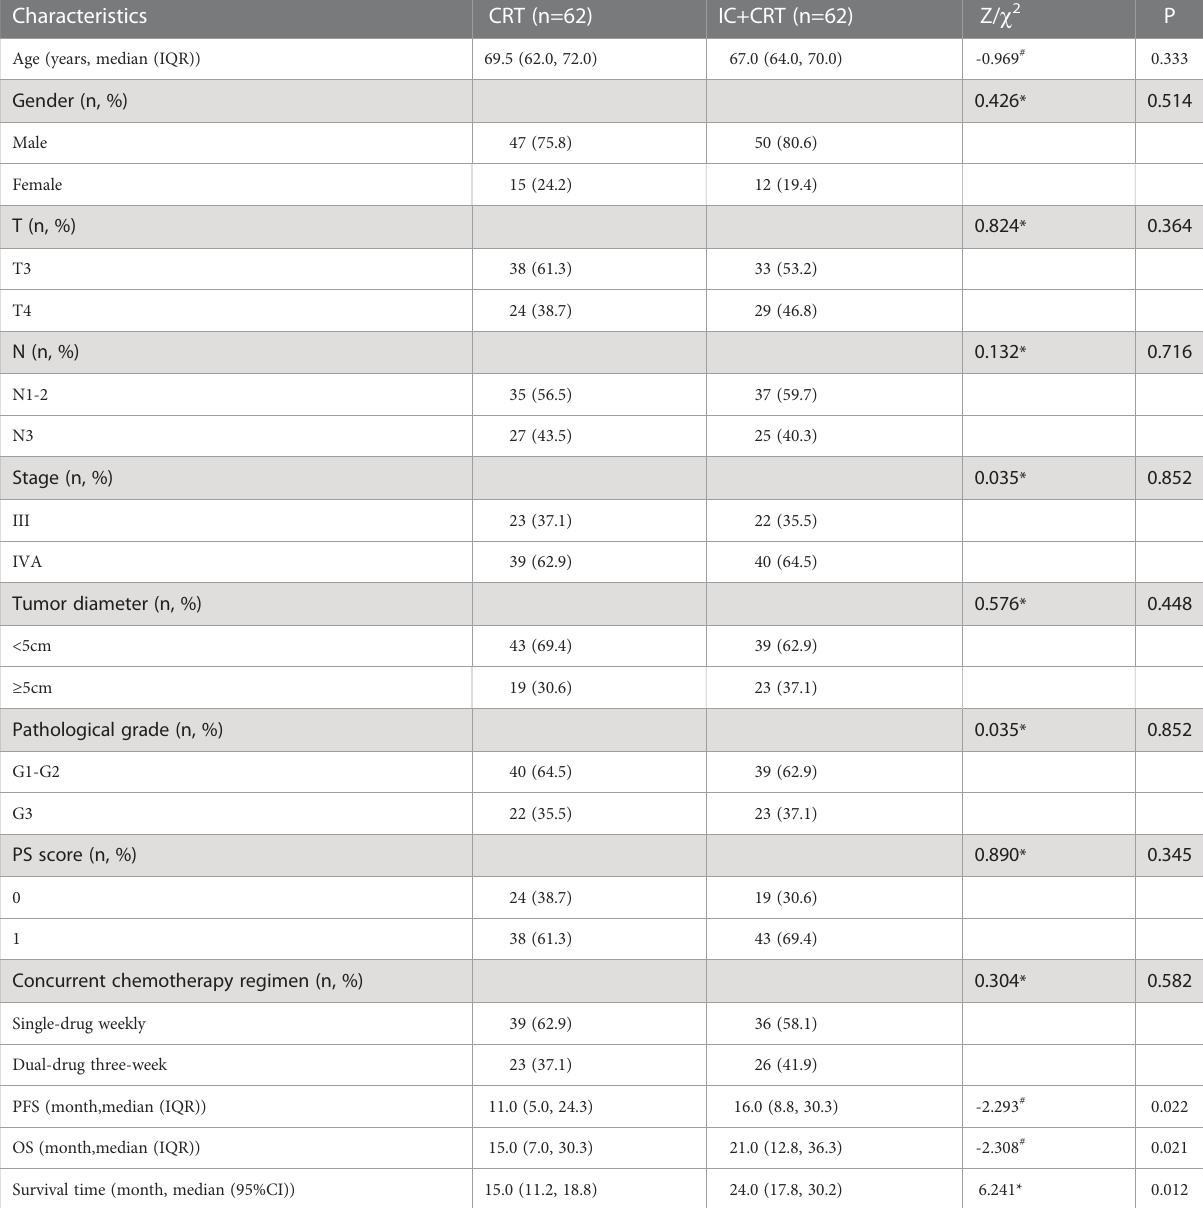
TABLE 1 Demographic and clinical characteristics of patients with